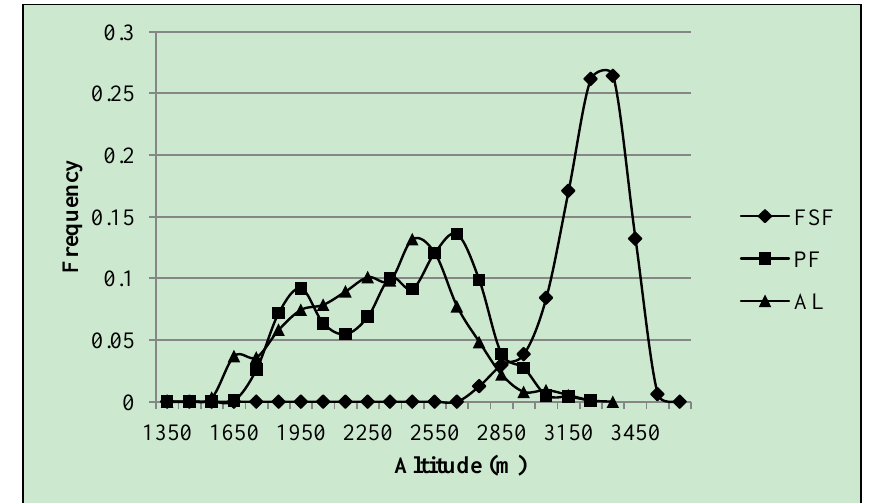
Figure 11. Frequency distribution of DEM values for FSF, PF and